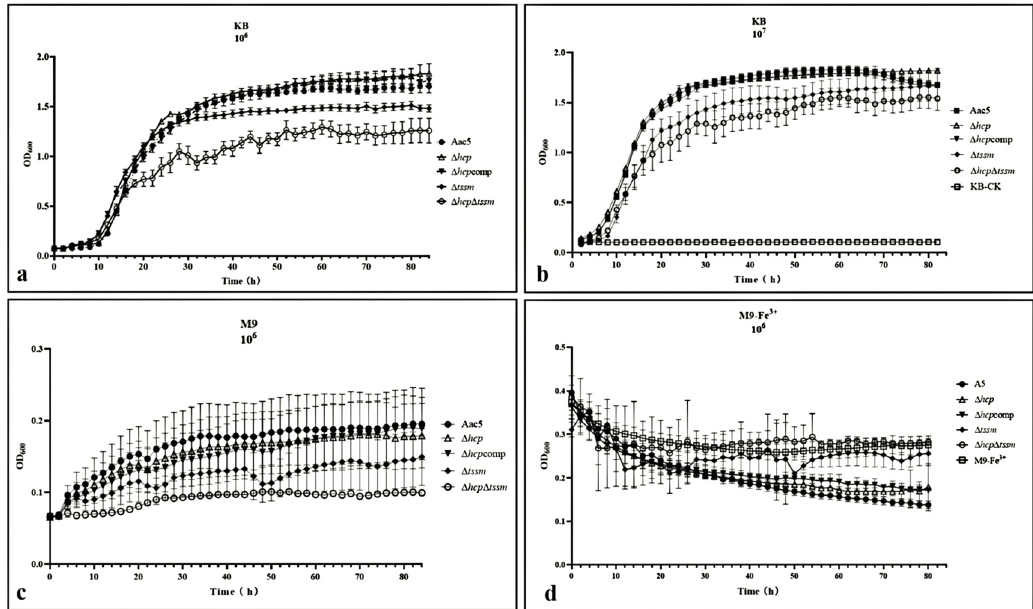
Figure 2. Growth ability of Acidovorax citrulli WT Aac5, Δ hcp , Δ hcp comp, Δ tssm , and Δ hcp Δ tssm in